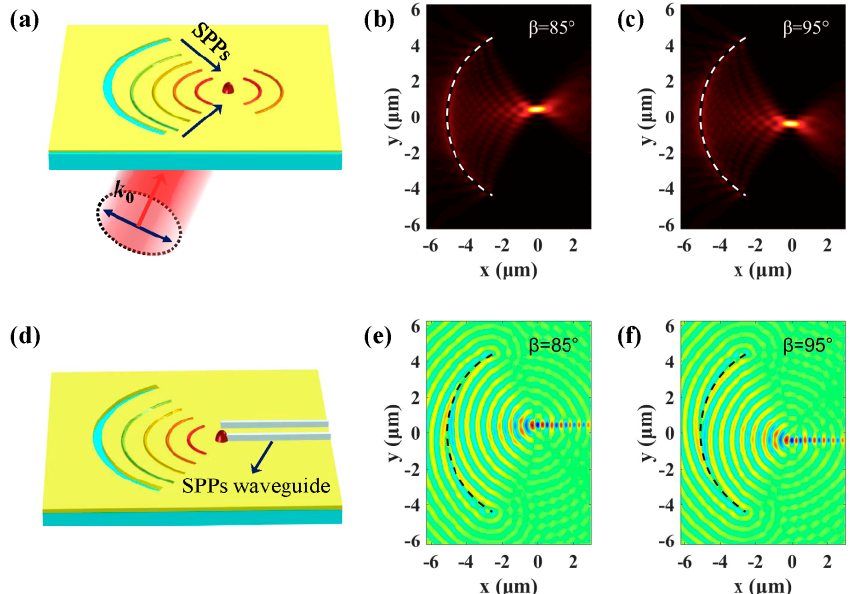
Figure 4. ( a ) Schematic diagram of an arc-shaped slit plasmonic lens illuminated by oblique incident light. ( b , c ) are the intensity distributions of SPPs generated by the β = 85 ◦ and β = 95 ◦ excitation light. ( d ) Two SPP waveguides are added to realize angular multiplexed SPP propagation. The real parts of SPPs in ( e , f ) show that the SPPs can be selectively coupled to the upper or lower SPP waveguide by changing the spatial frequency.